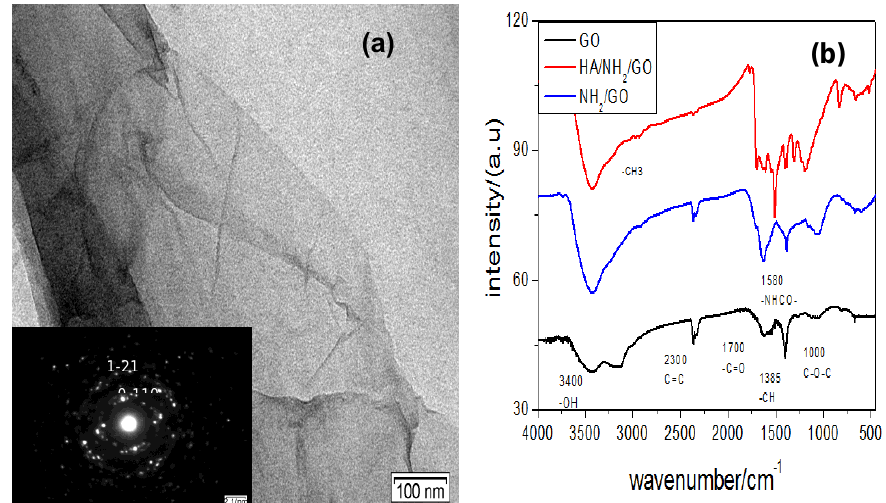
Figure 2. ( a ) TEM diagram of hyaluronate-functionalized graphene (HG), and ( b ) FTIR spectra of graphene oxide (GO), NH 2 /GO, and HG.